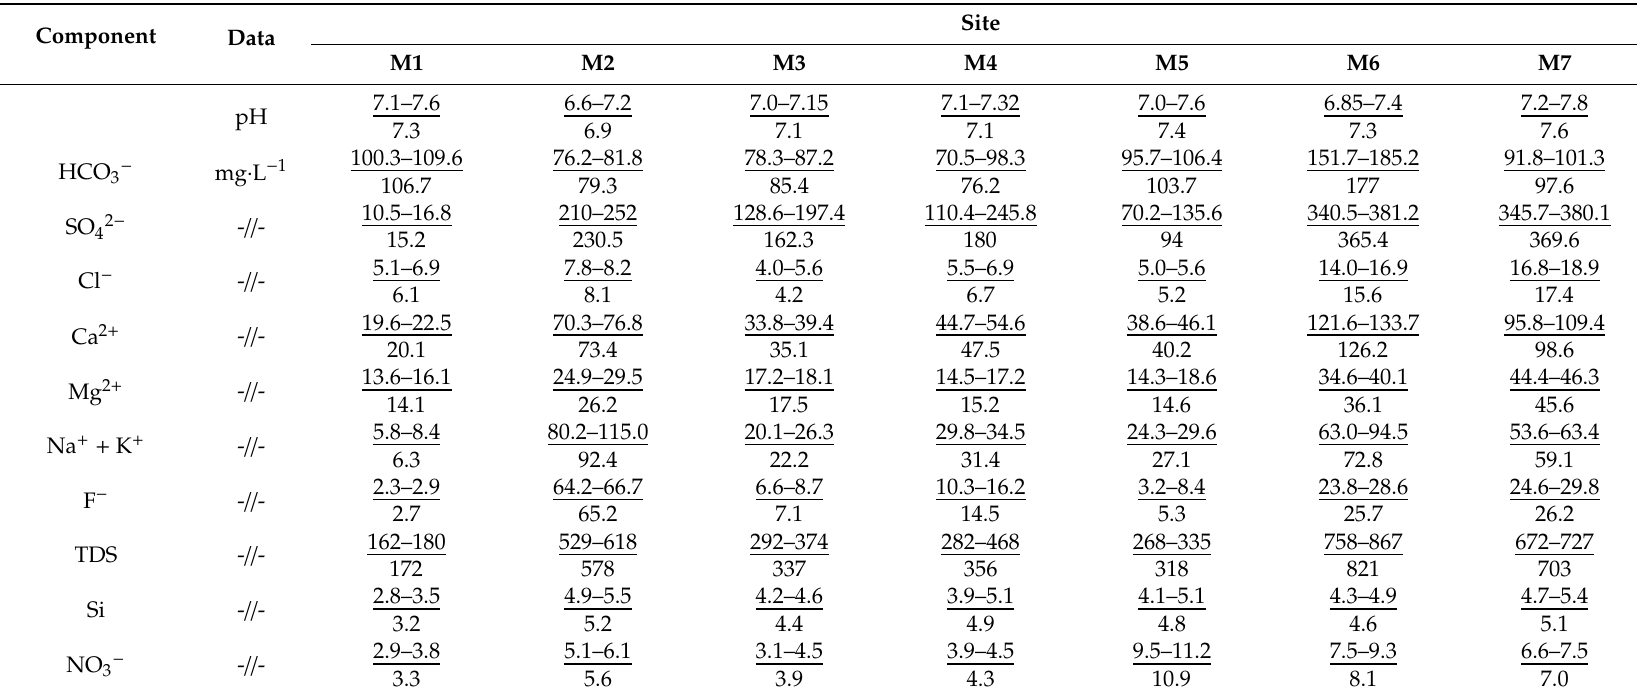
Table 2. The concentrations of main ions and total dissolved solids (TDS) of the river Modonkul in the period